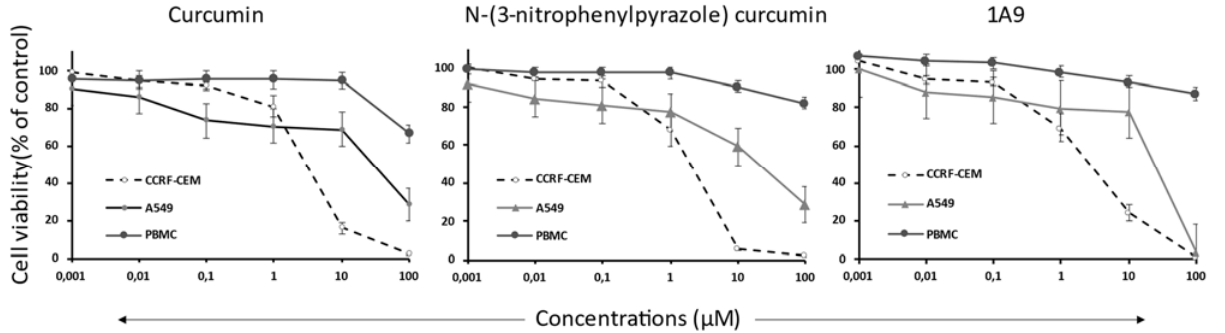
Figure 5. Cell viability dose ‐ response curves of CCRF ‐ CEM leukemia cells, A549 lung carcinoma cells, and healthy peripheral blood mononuclear cells treated with curcumin, 1A9, and N ‐ (3 ‐ nitro ‐ phenylpyrazole) curcumin as determined by the resazurin assay. Cells were incubated with concen ‐ trations from 10 − 3 to 100 μ M and incubated at 37 °C for 72 h. DMSO was used as vehicle control. Mean ± SD of three independent measurements. Table 2. IC 50 values of CCRF ‐ CEM leukemia and A549 lung carcinoma cells treated with curcumin, 1A9, and N ‐ (3 ‐ nitrophenylpyrazole) curcumin as determined by the resazurin assay. The IC 50 values ( μ M) were calculated from the dose ‐ response curves shown in Figure 5. DMSO was used as vehicle control. Mean ± SD of three independent measurements.